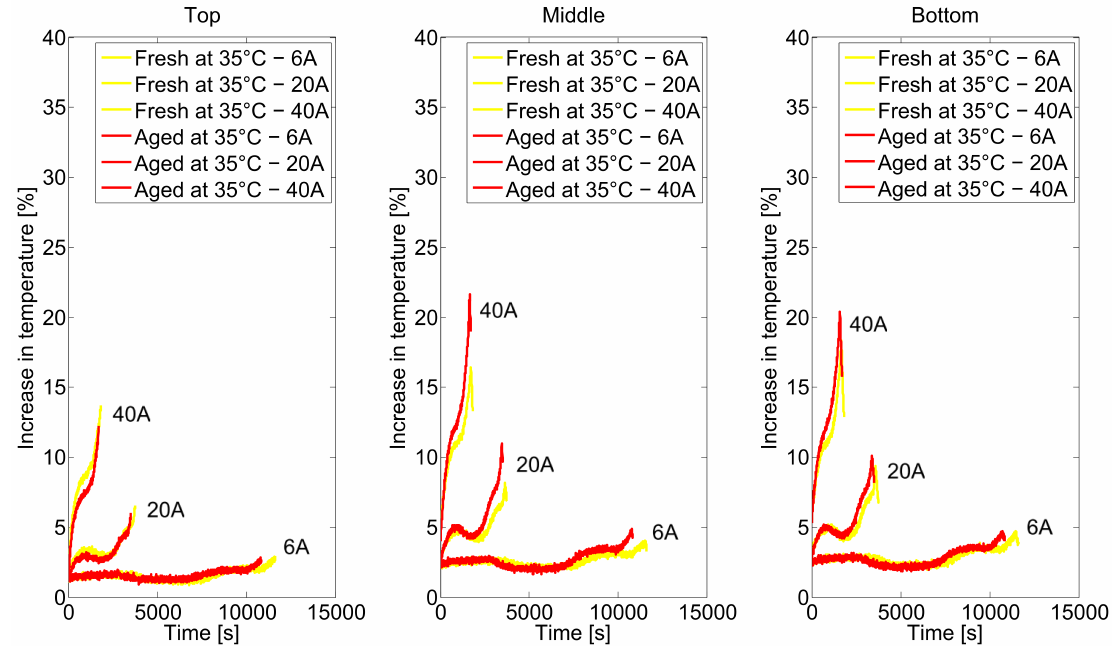
Figure 15. Temperature increase at 35 ◦ C for fresh and aged